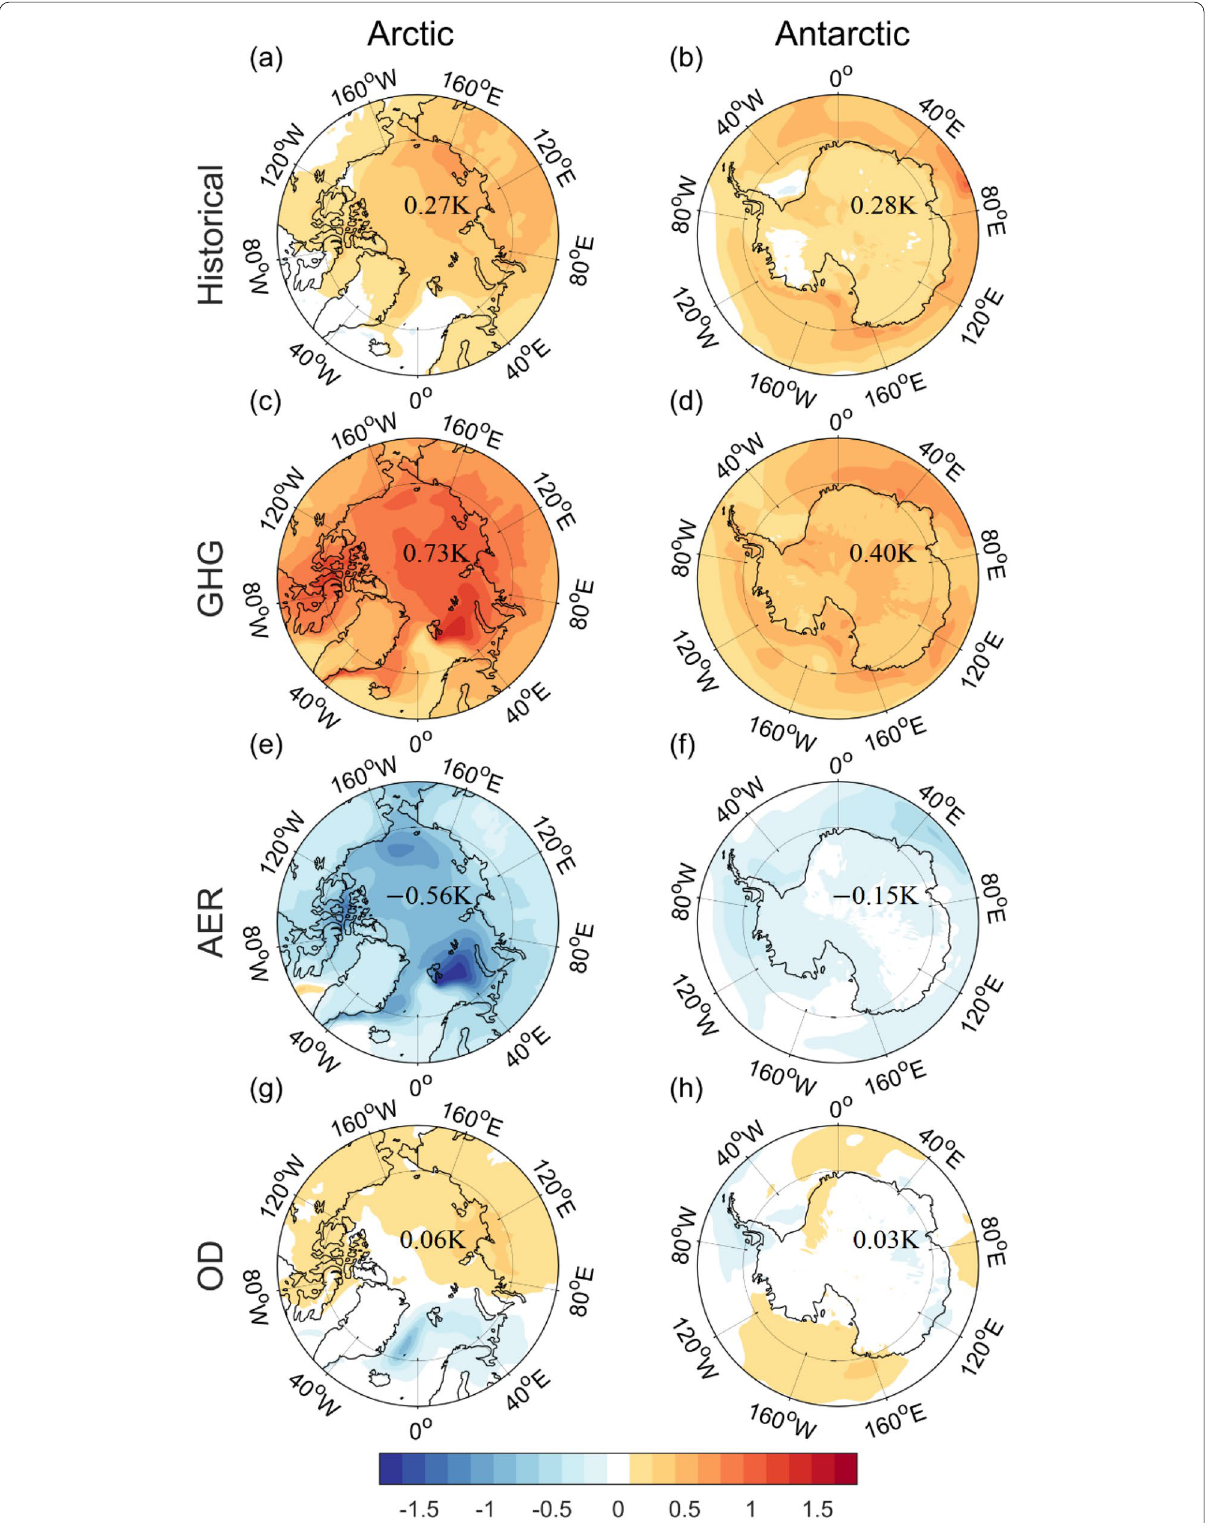
Fig. 2 Surface temperature changes ( K ) in the a , b historical simulation and the contributions from c , d GHG, e , f AER, and g , h OD over the two polar regions during 1955–2000 relative to 1945–1965 for GHG and AER and 1955 for OD. The area-weighted surface temperature anomalies are labeled in the corresponding